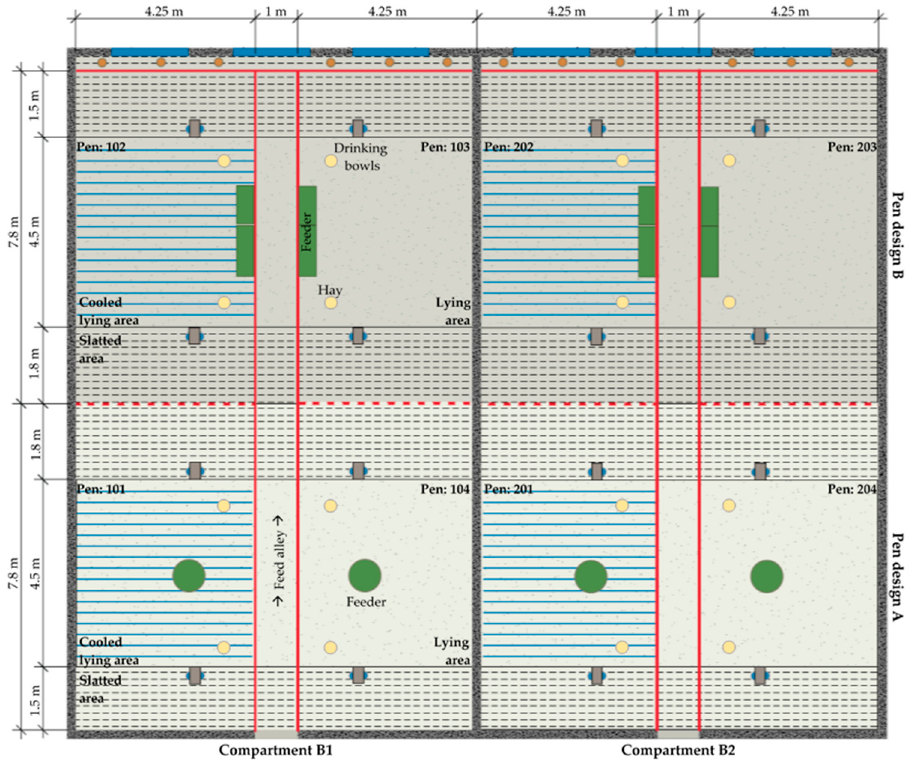
Figure 1. Two compartments with the experimental pen designs A and B.